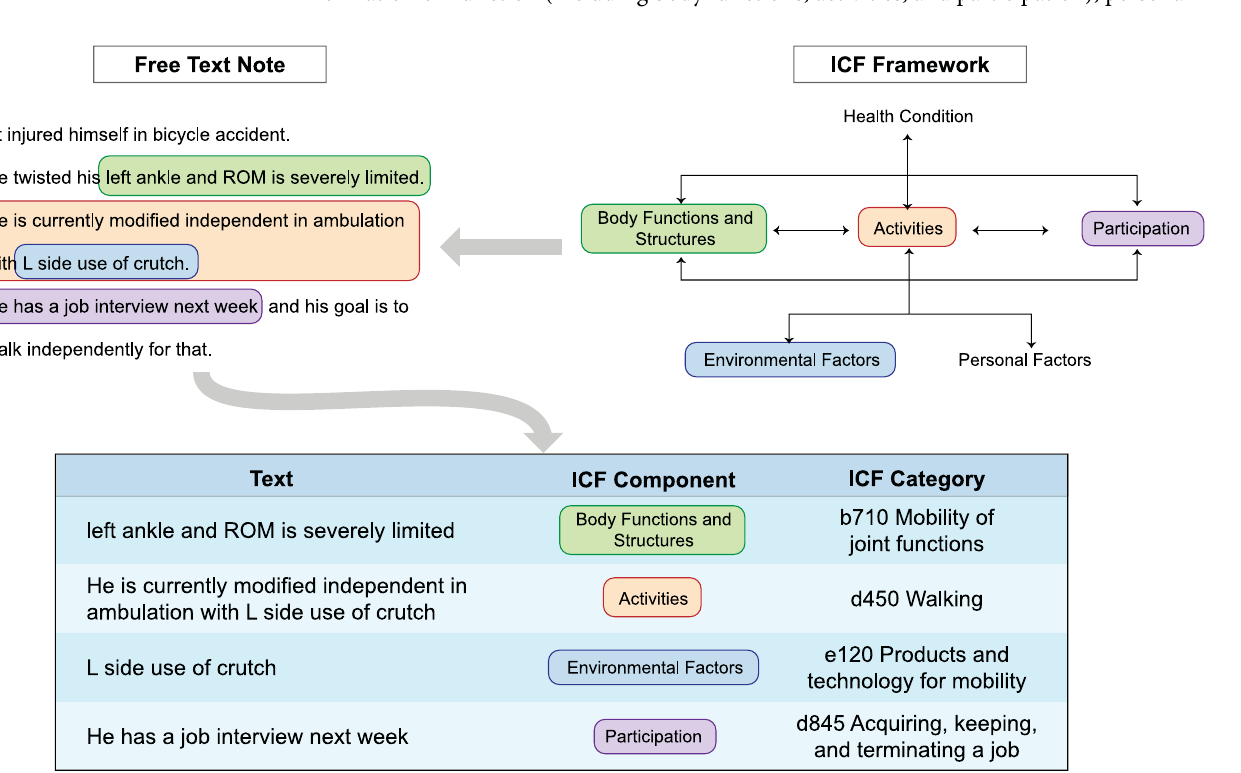
PLOS Digital Health | https://doi.org/10.1371/journal.pdig.0000135 November 17,